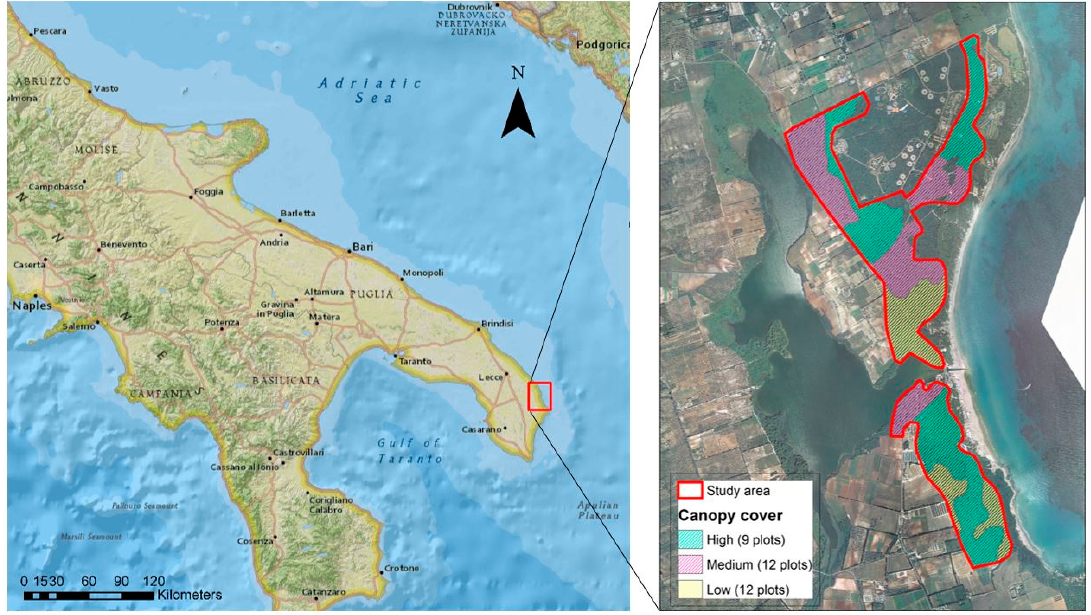
Figure 1. Location of the study area, and plot distribution across three sampling strata, defined according to the predominant canopy cover.